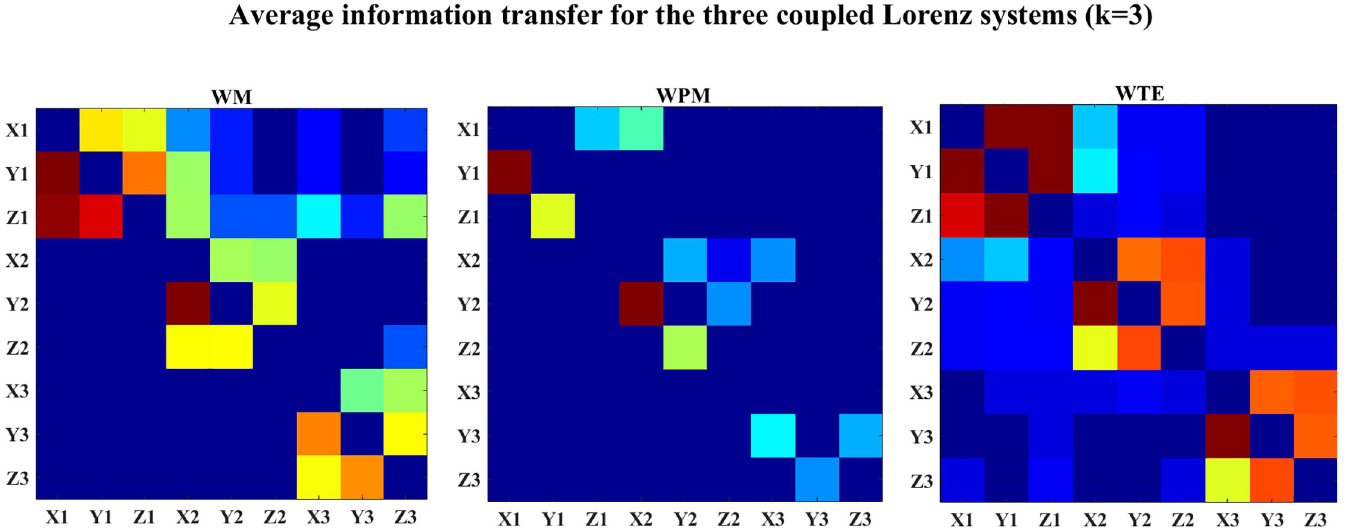
Fig 16. The color-map of the average information transfer for the three coupled Lorenz systems (k = 3). This figure shows the color-map for the average WM (left), WPM (middle) and WTE (right) information transfer (coupling strength k = 3) over time scales. The directed direction of each lattice is indicated from the row to the column channel. The bright diagonal blocks of WM and WPM indicate internal interaction within each system. In the WM and WPM graphs, the upper-right blocks are comparatively brighter than the lower-left blocks, which indicates the interactions between the systems. WPM indicates only direct interactions from the first to the second system and from the second to the third system, but no indirect interaction from the first to the third system. WTE presents similar strength of information transfer on both directions between coupled variables.